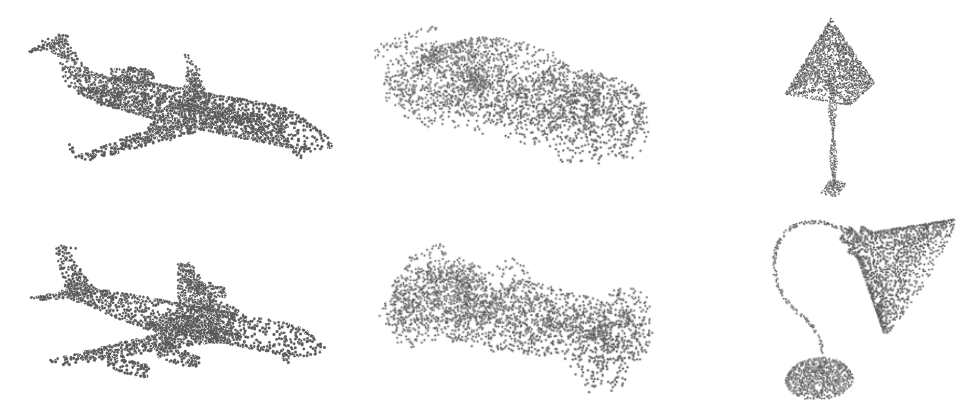
Figure 2. Airplanes, cars, and lamps examples in PCN